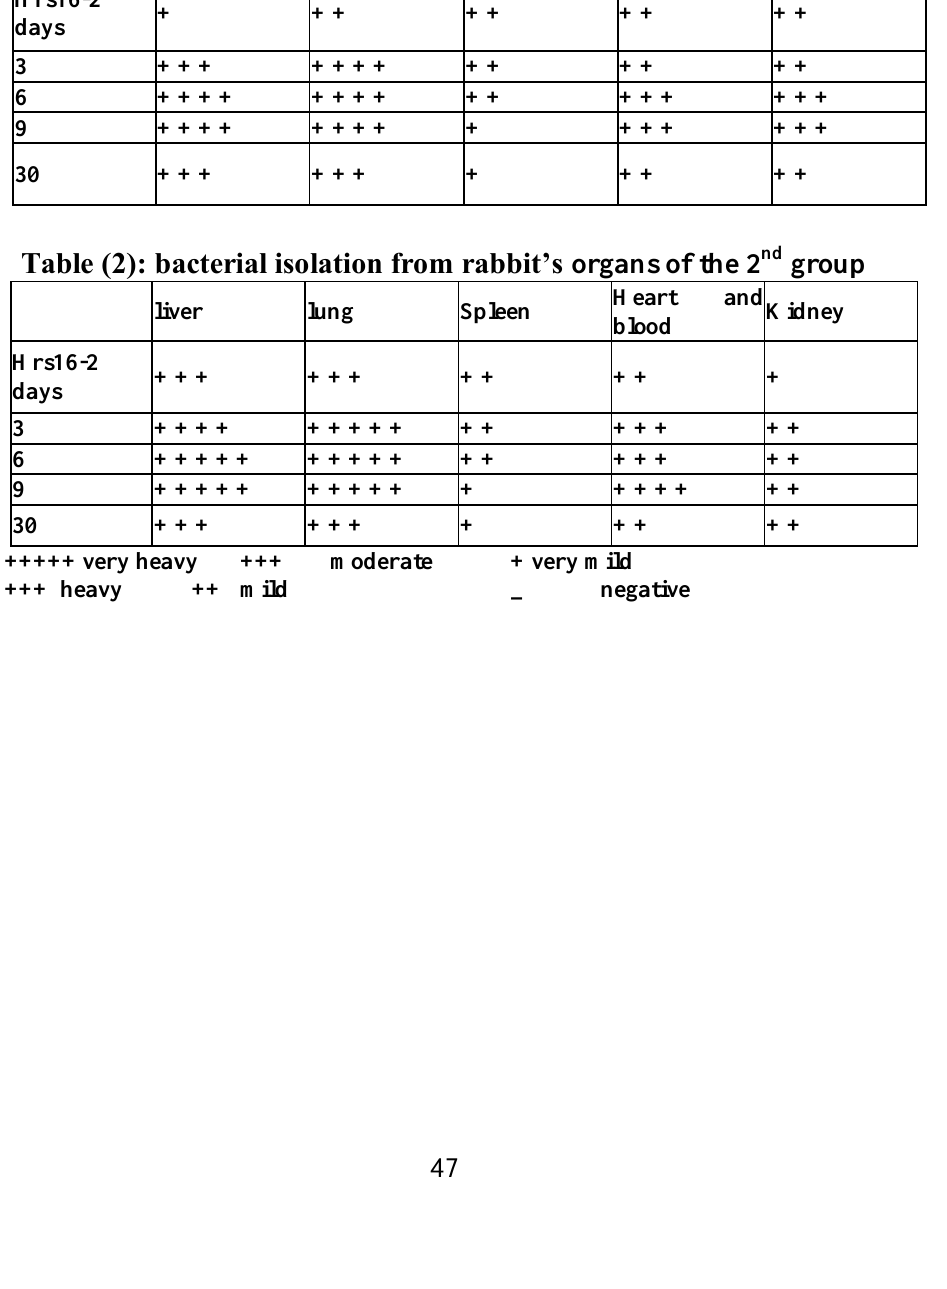
Table (1): bacterial isolation from rabbit’s organs of the 1 st group liver lung